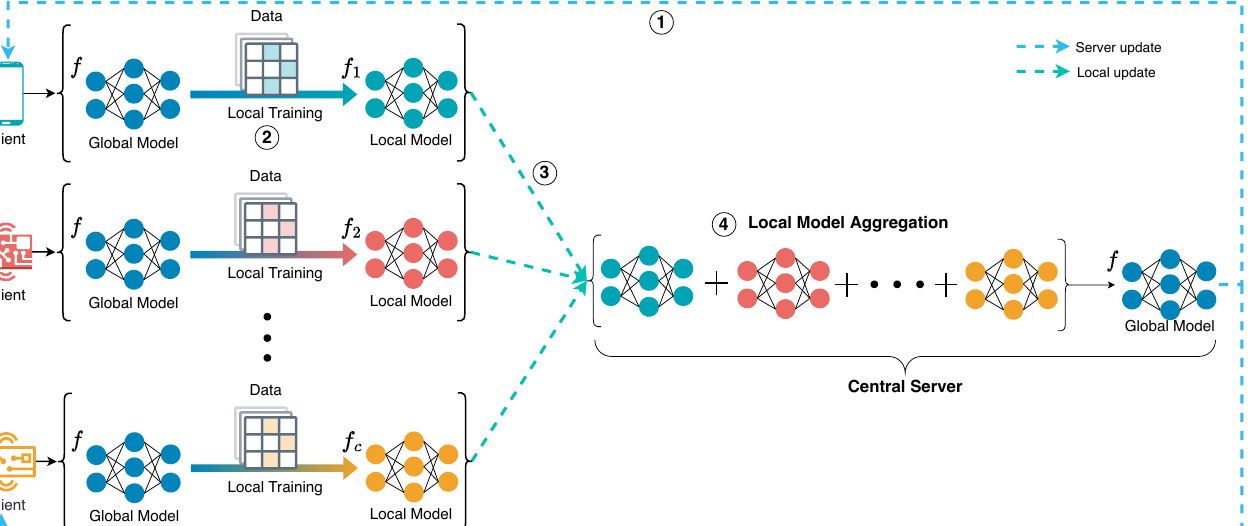
Figure 1: (cid:172) A central server broadcasts the global model to all clients; (cid:173) all clients train